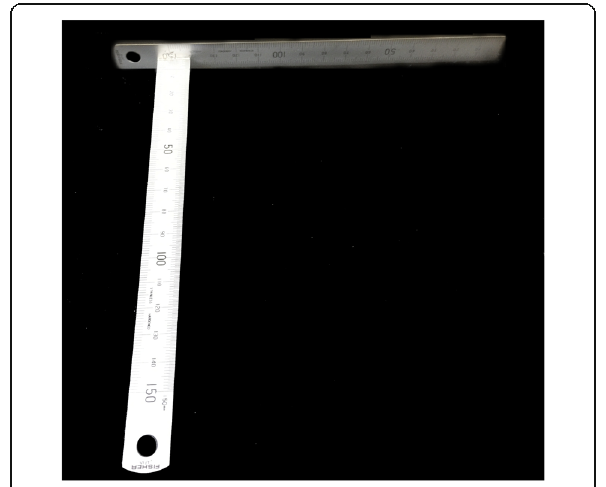
Fig. 1 The measuring instrument is constructed by soldering the edge of a double-sided stainless steel dental ruler at 90° to the flat surface of a similar ruler. A double-sided ruler permits its use on the patient ’ s right and left sides as required. A right-angle gauge may be used to ensure a 90° angle